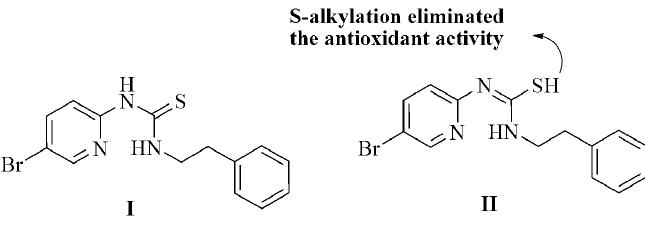
Figure 2. Thiol-thione tautomerism and S-alkylation in phenethyl-5-bromo-2-pyridyl thiourea.